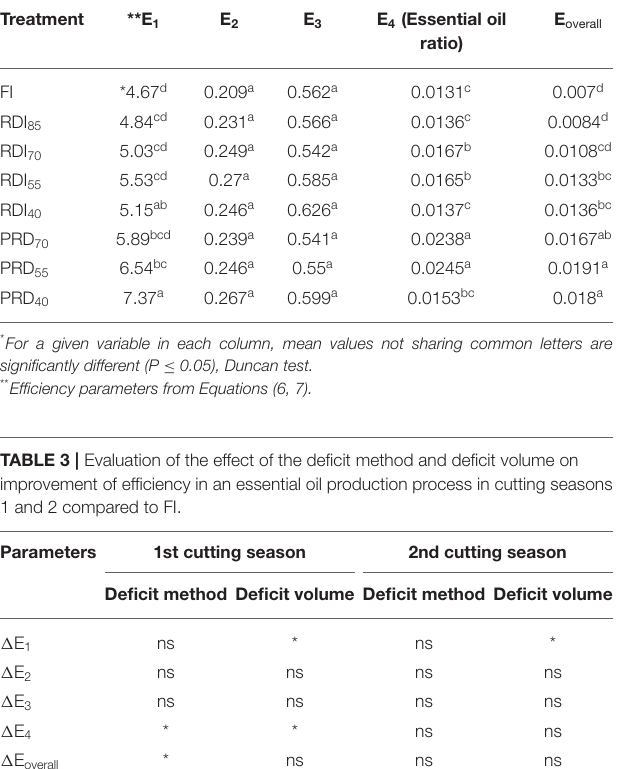
TABLE 2 | The efficiency of each step in an essential oil production process in cutting season 1. Treatment